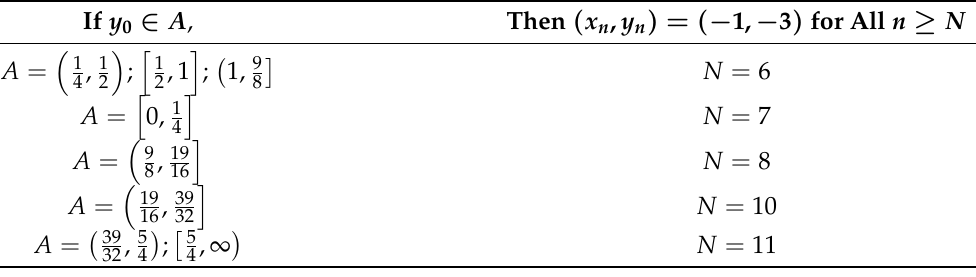
Table 5. Cases for x 0 = 0 and y 0 ≥ 0.